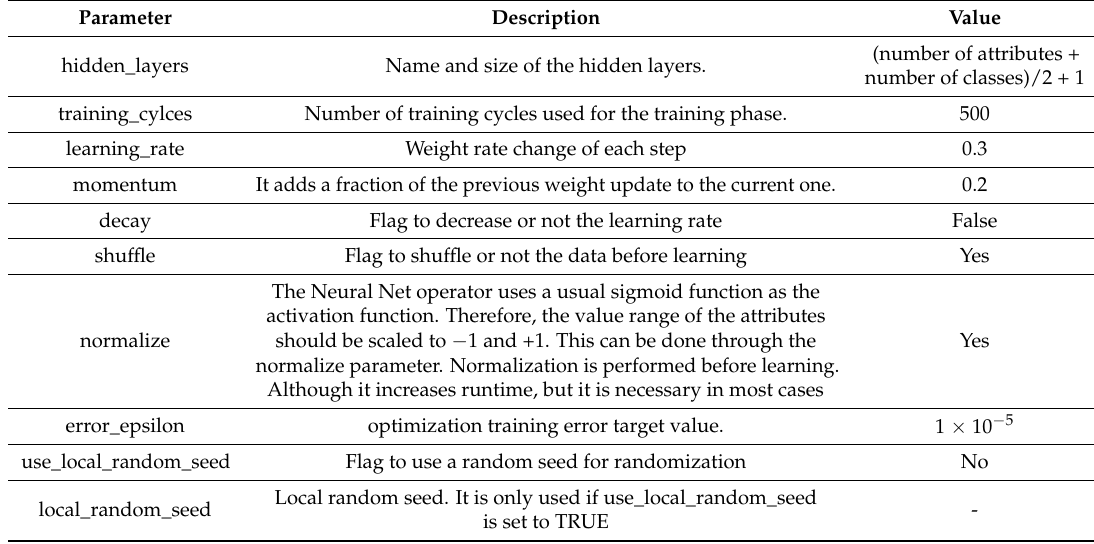
Table 2. Setting configuration for the MLP network.